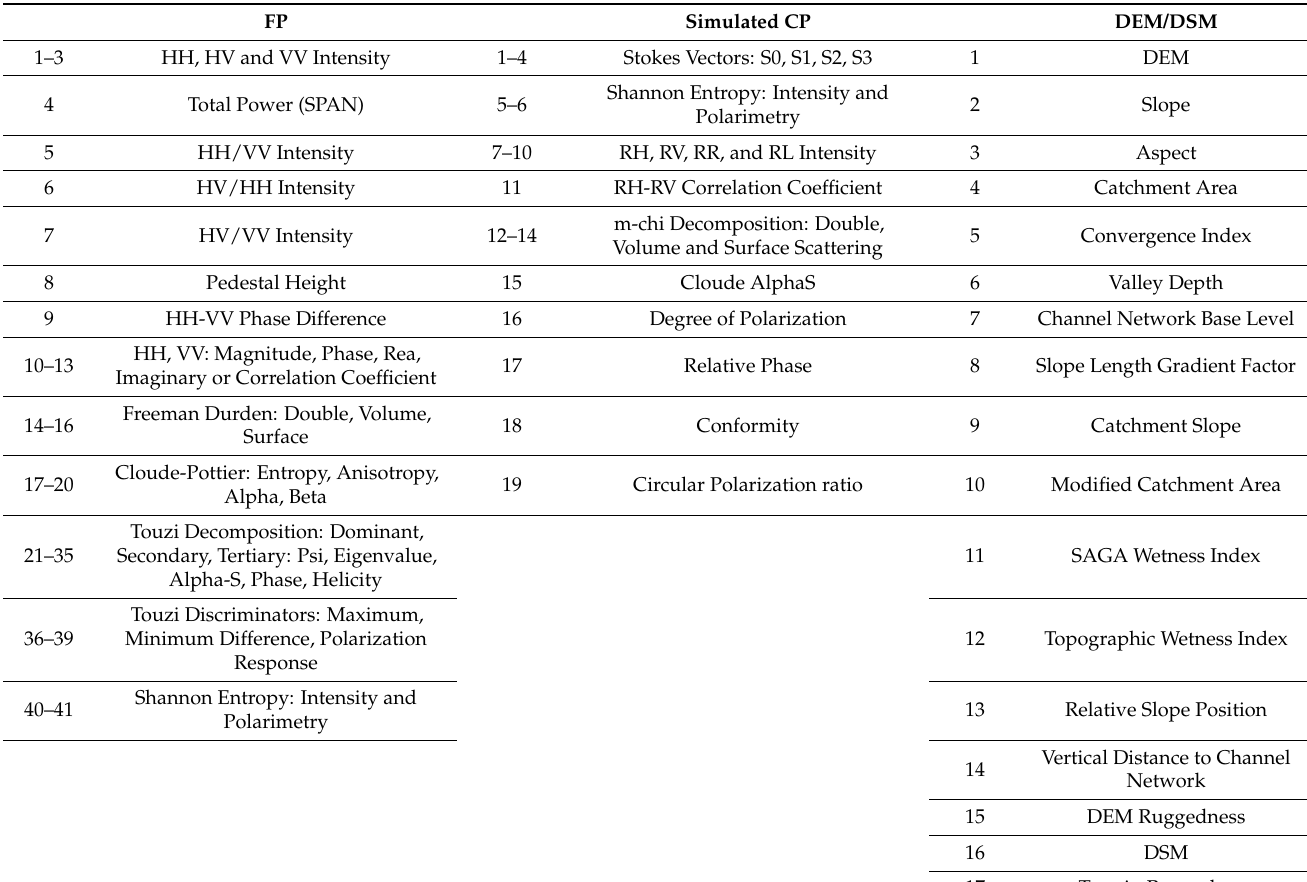
Table 6. List of variables used as inputs to Random Forests, derived from quad pol RADARSAT-2 imagery (FP), simulated compact pol data (Simulated CP), and DEM/DSM